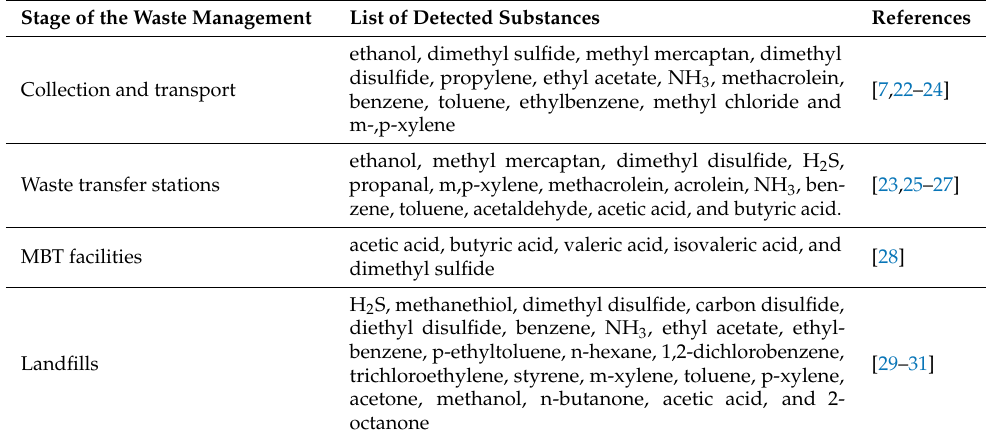
Table 1. Chemical composition of odorous mixtures from different stages of waste management.